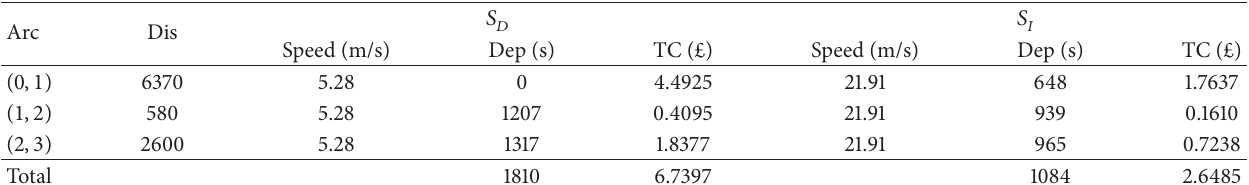
Table 1: Results in Example 1.